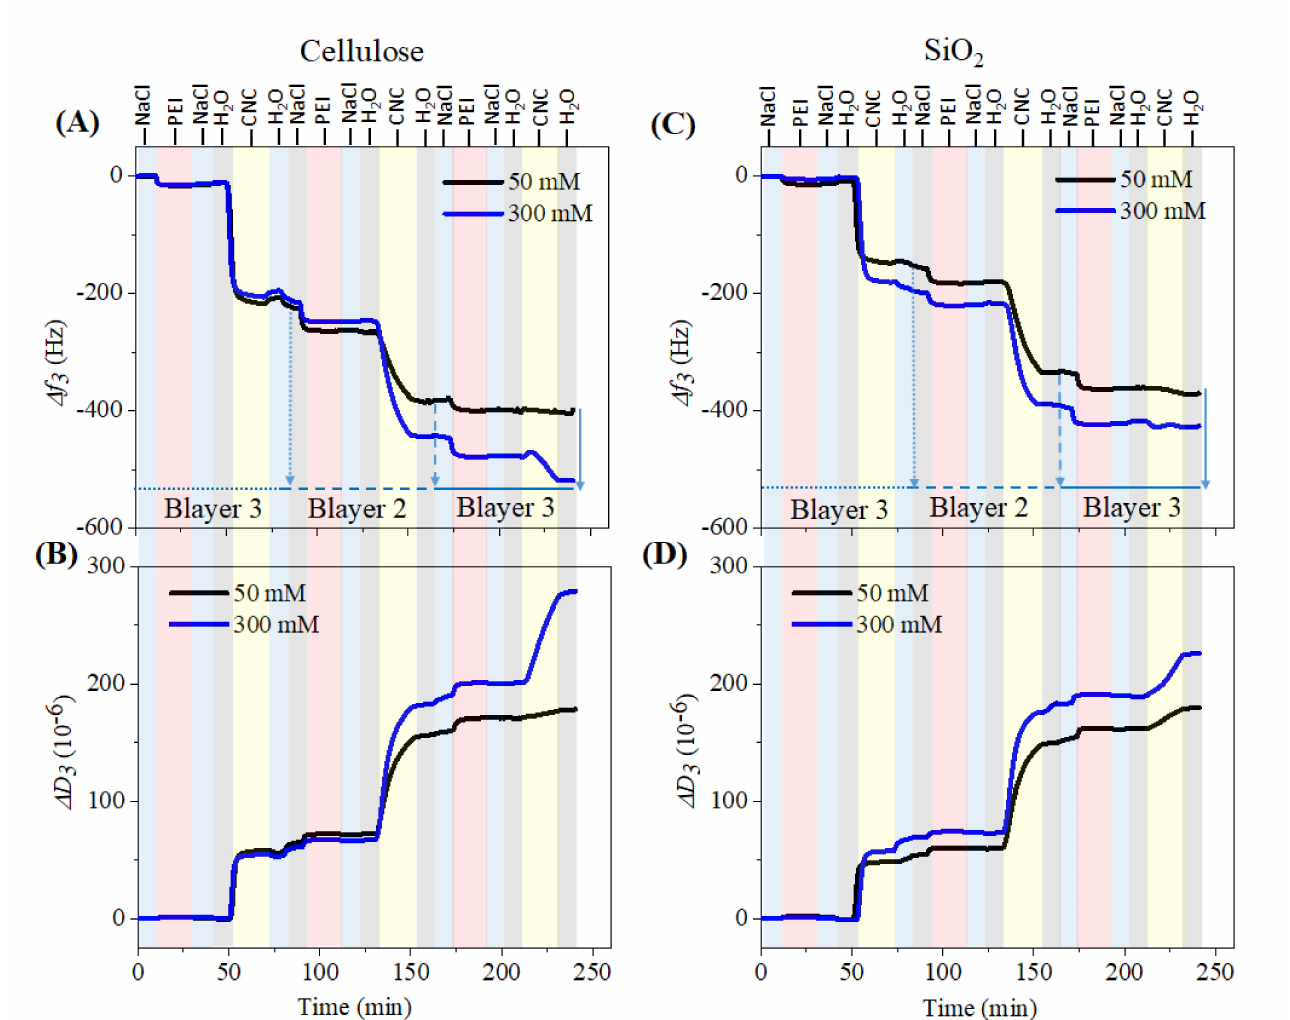
Figure 2. QCM-D change in frequency and dissipation for the sequential adsorption of polyethylenimine (PEI) and CNCs on SiO 2 ( A , B ) and cellulose ( C , D )